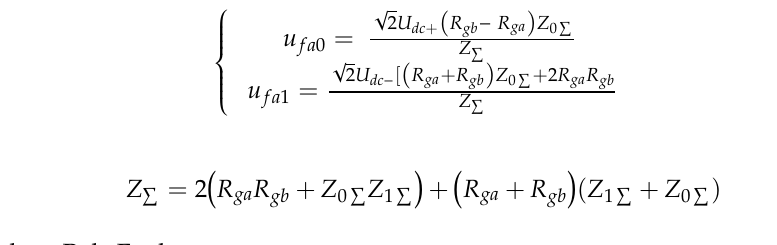
Figure 12. Sequence network connections for pole-pole to ground fault.